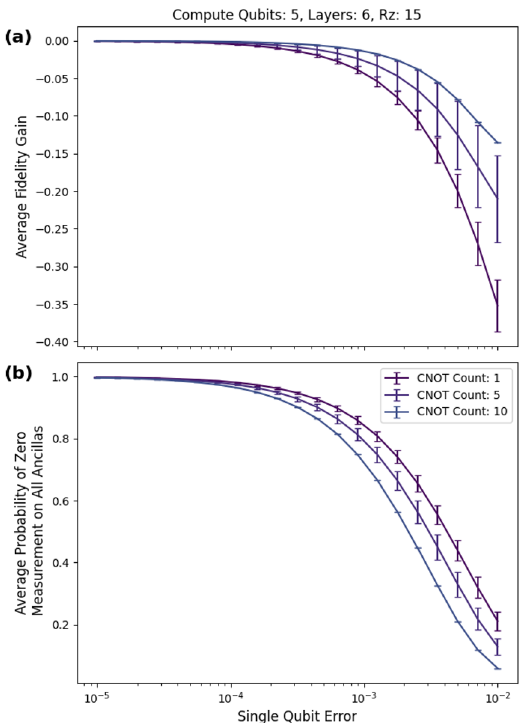
Figure 14. Five-qubit circuits with 15 rz gates. After 10 cnot gates, we cannot find circuits with six layers.